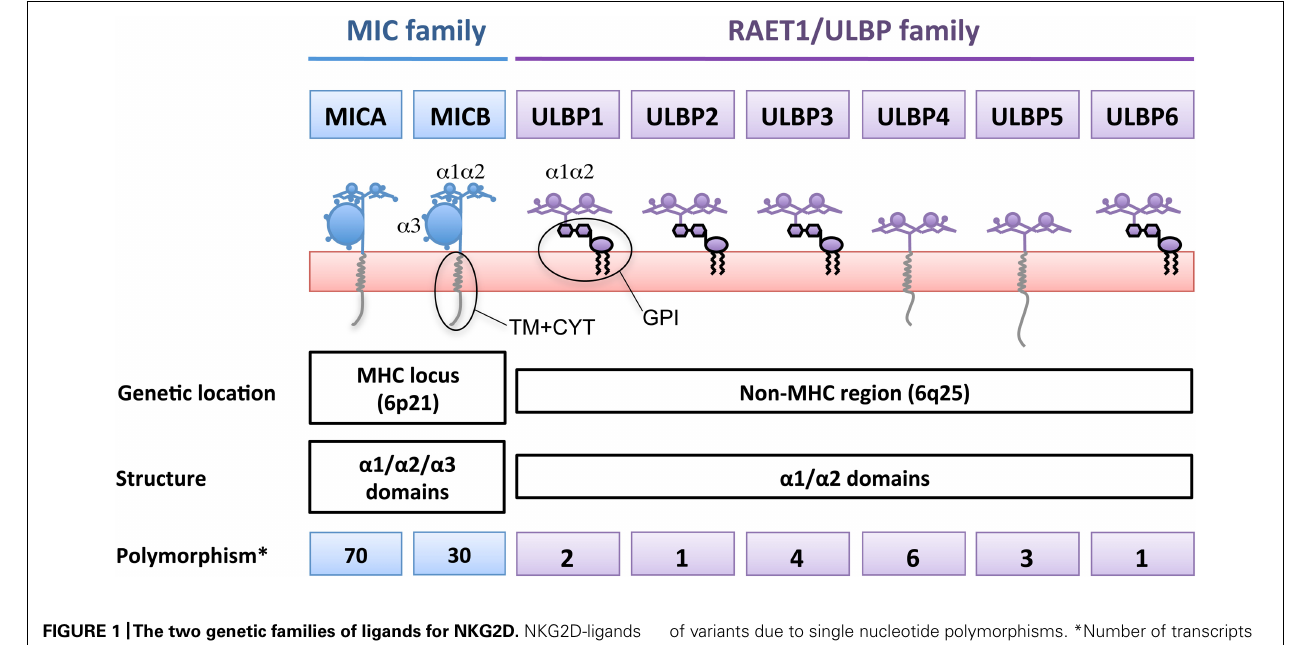
FIGURE 1 |The two genetic families of ligands for NKG2D. NKG2D-ligands belong to two genetic families present in different arms of chromosome 6, giving rise to a large number of proteins with different biochemical properties. MICA/B are highly polymorphic genes while ULBPs only have a small number